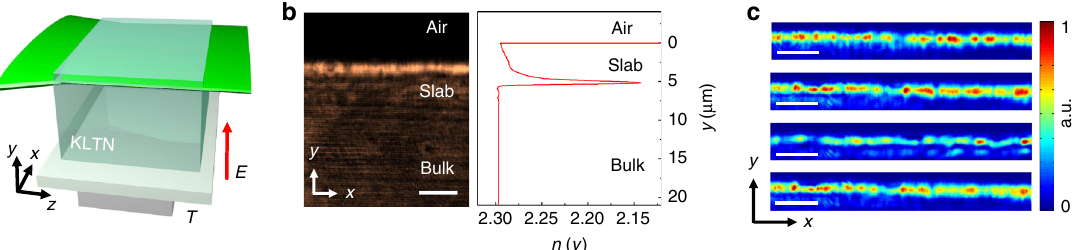
Fig. 1 Experimental setup. a Scheme for optical wave propagation in a photorefractive slab waveguide embedded in a KLTN cystal. b Output image of the linear transmission through the sample and corresponding refractive index pro fi le (see Methods). c Examples of the detected intensity in linear conditions for distinct realizations of the experiment showing different realizations of the disorder in the slab along x . Scale bars are 50